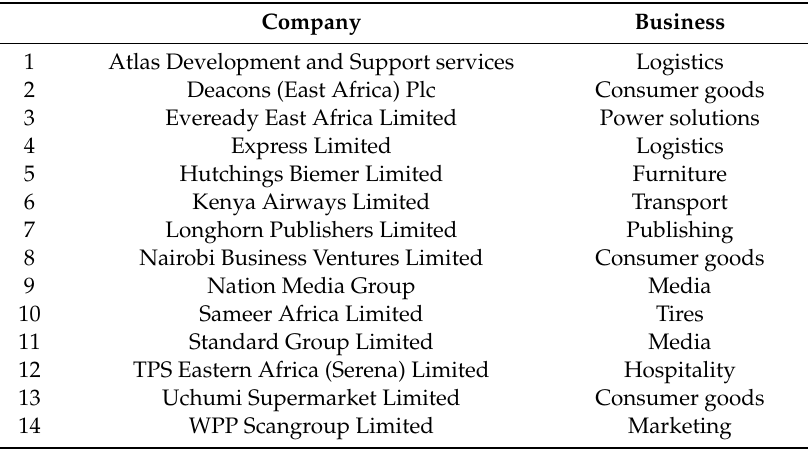
Table 2. Distribution of target